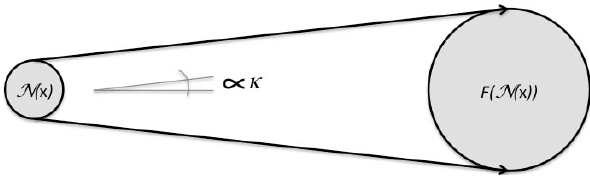
Fig. 2. Simple model for uncertainty propagation. The balls repre- sent uncertainty